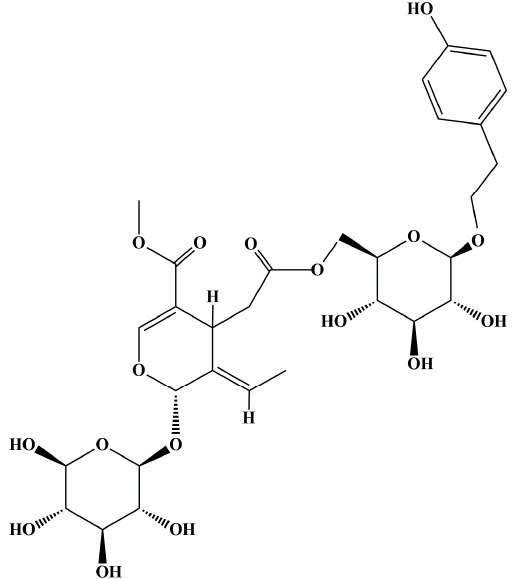
Figure 1. Structure of methyl (5 E ,6 S )-5-ethylidene-4-[2-oxo-2-[[(2 R ,3 S ,4 S ,5 R ,6 R